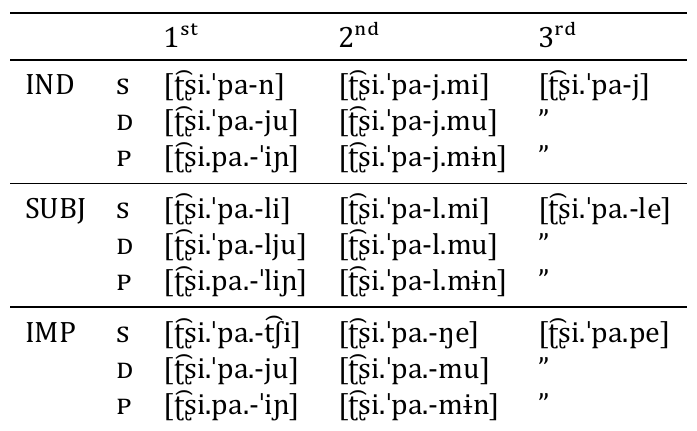
Table 4: PDM verbal paradigm for the vowel-(cid:976)inal root [ʈ͡ʂipa-] ‘exit’